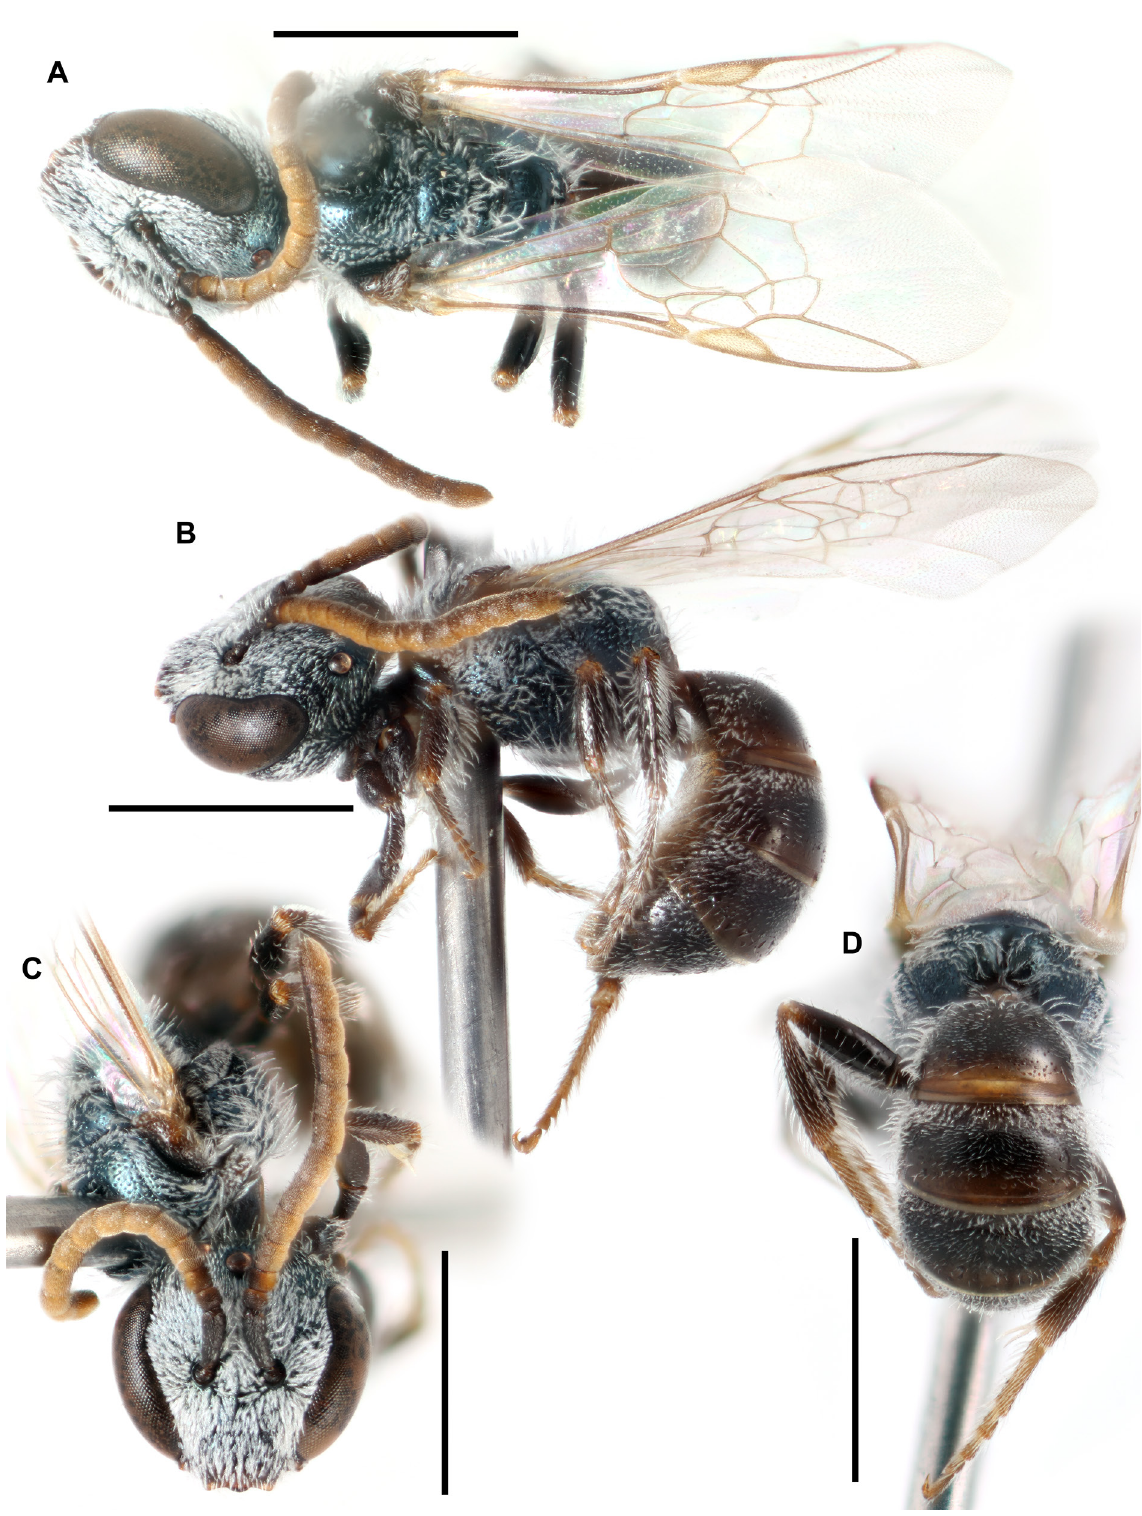
Fig. 37. Lasioglossum ( D .) indagator sp. nov., ♂ (WRME 518968). A . Dorsal habitus. B . Lateral habitus. C . Face. D . Metasoma and propodeum. Scale bars = 1